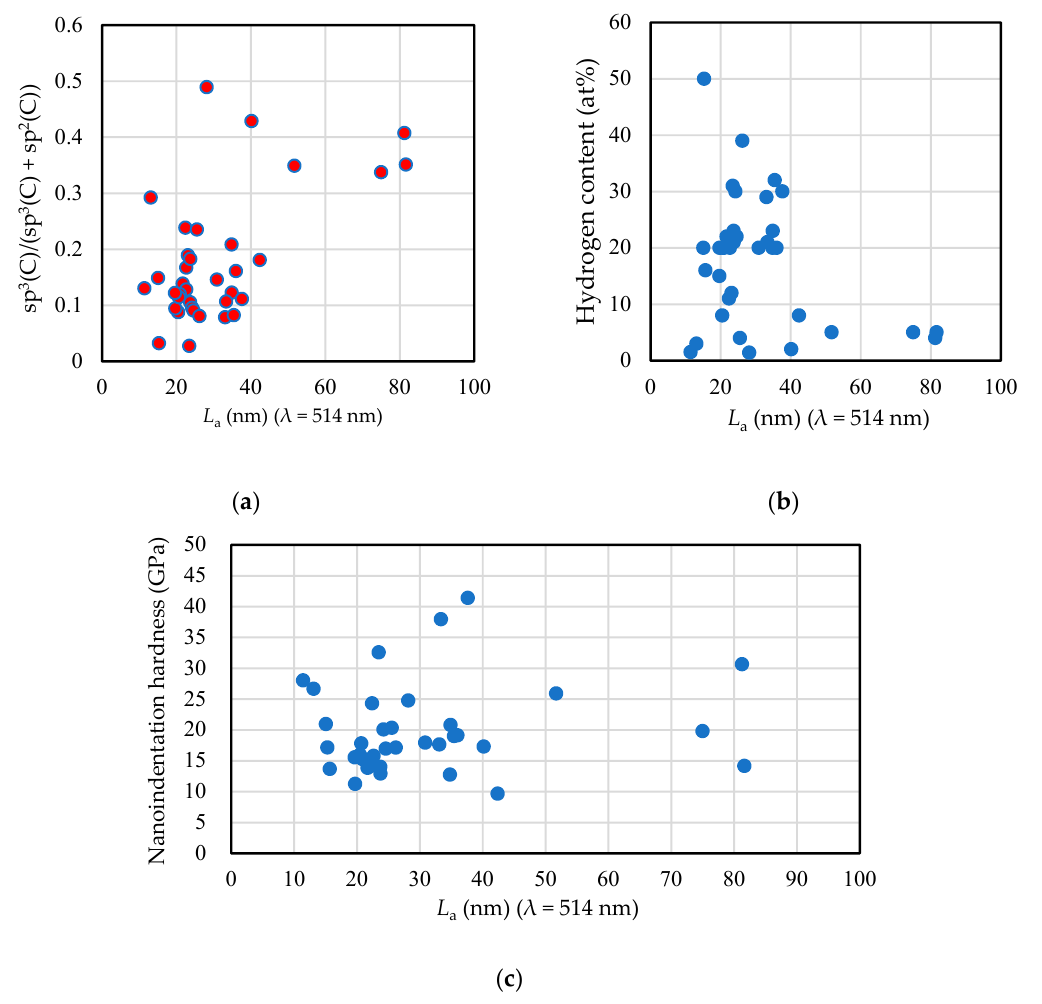
Figure 16. Relations between sp 3 (C)/(sp 3 (C) + sp 2 (C)) ( a ), hydrogen content ( b ), and nanoindentation hardness ( c ) of amorphous carbon films and the grain size of sp 2 L a . The laser line wavelength λ is 514 nm. Table 4. Classification of amorphous carbon films including DLC films, and those with industrial